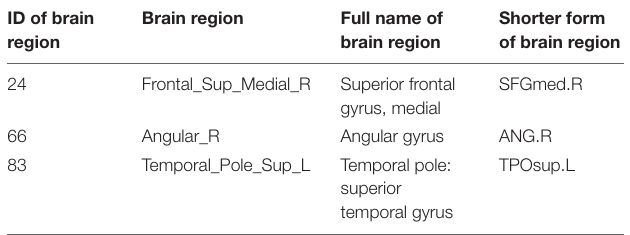
TABLE 5 | The brain regions with a frequency of